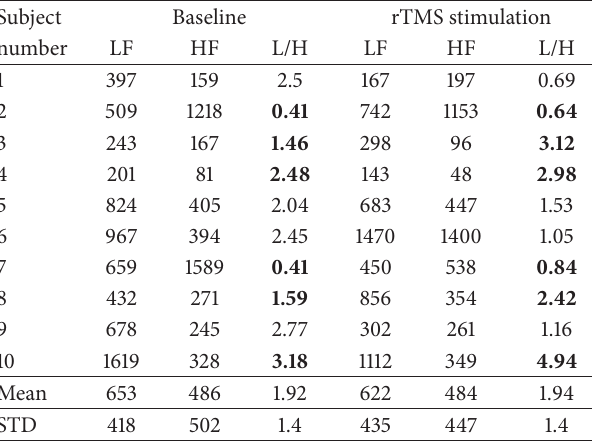
Table 3: Differences in HRV (as determined from spectral analysis: LF and HF).